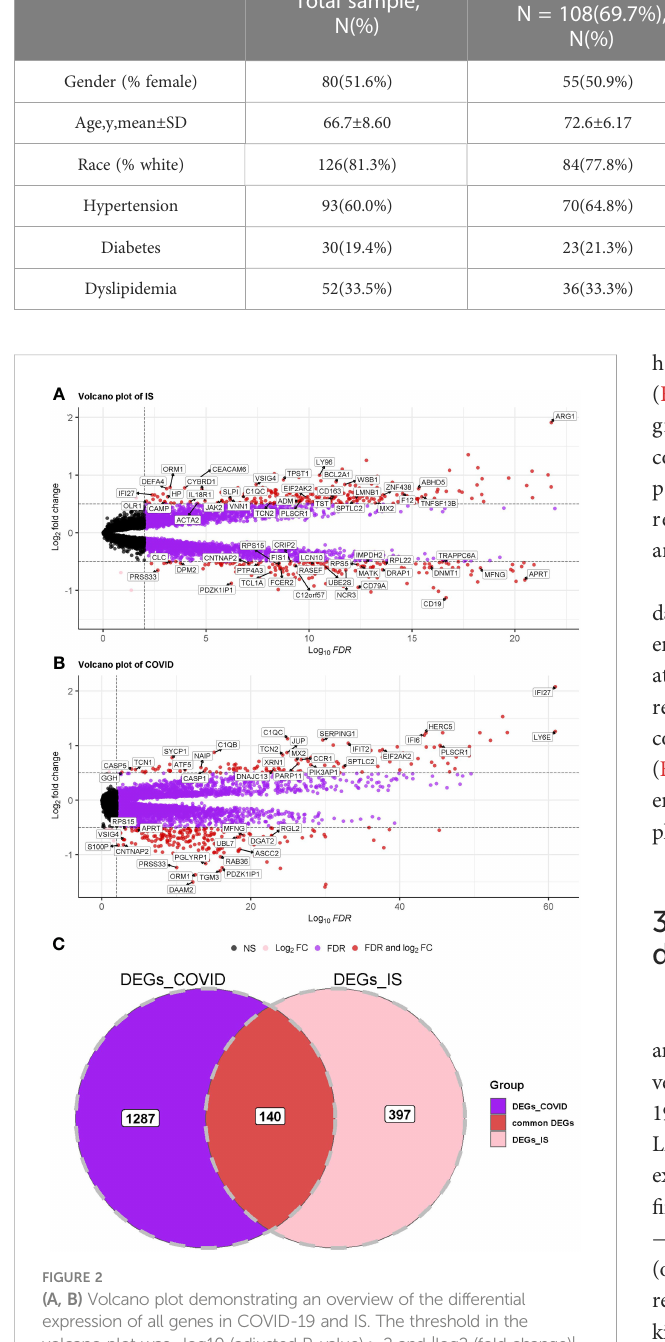
FIGURE 2 (A, B) Volcano plot demonstrating an overview of the differential expression of all genes in COVID-19 and IS. The threshold in the volcano plot was -log10 (adjusted P-value) > 2 and |log2 (fold change)| > 0.5; red dots indicate signi fi cant differential expressed genes. FDR was used (Benjamini Hochberg ’ s) for P value adjustment. (C) Venn diagram demonstrates the common DEGs of COVID-19 and IS.